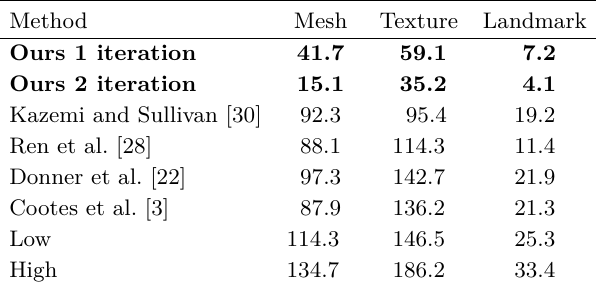
Fig. 7. Additional results and potential applications are shown in the Electronic Supplementary Material.